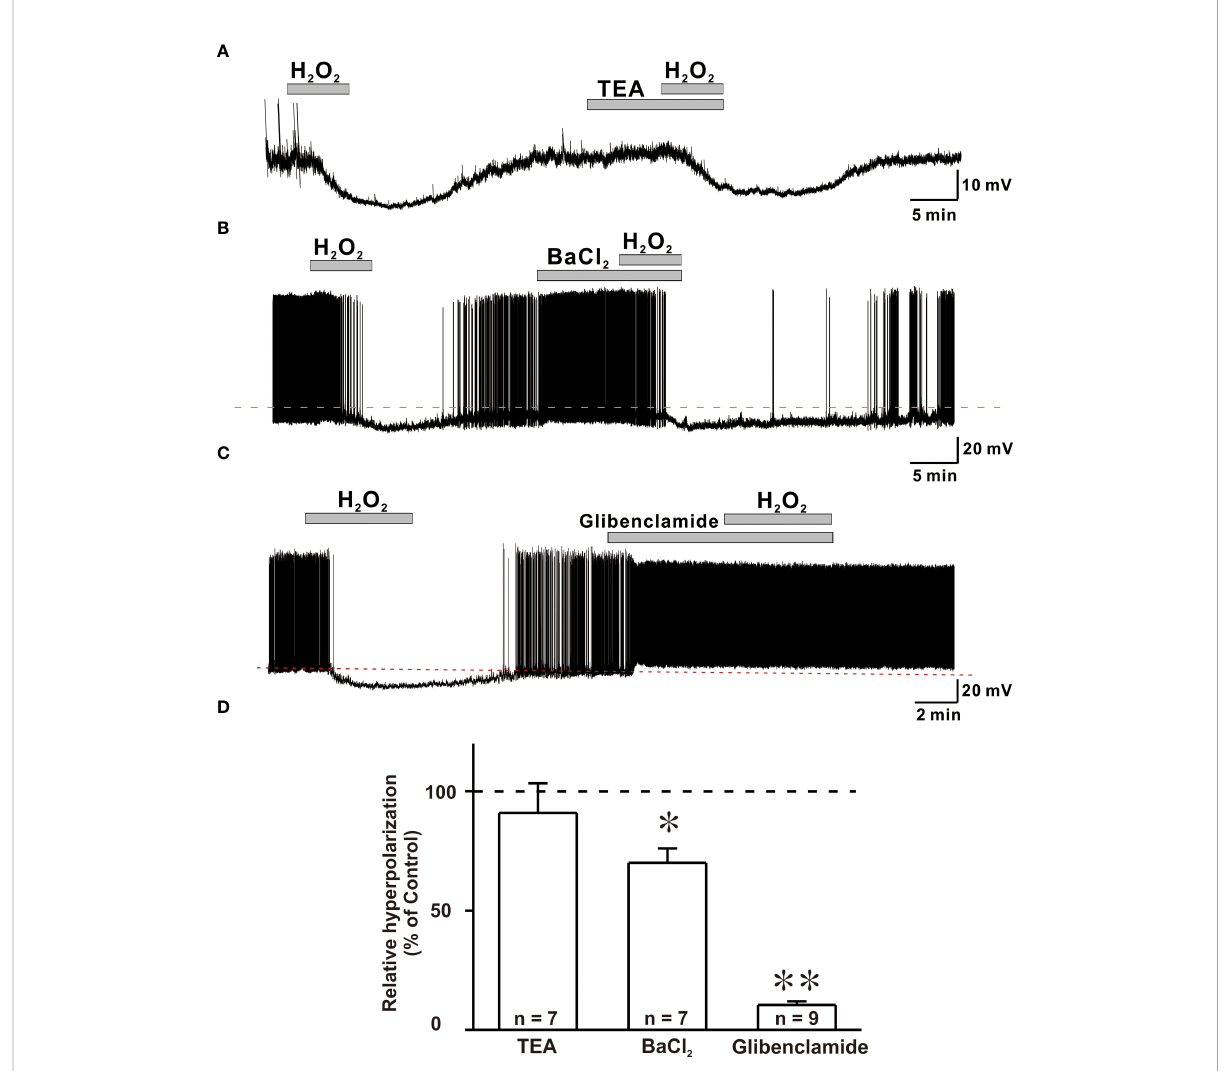
FIGURE 5 ATP-sensitive potassium channels (KATP) are susceptible to H2O2-induced hyperpolarization in GnRH neurons. (A, B) Representative traces showing persistence of H2O2-induced hyperpolarization response in the presence of TEA and BaCl2, respectively. (C) A representative trace showing complete blockade of hyperpolarization induced by 1mM H2O2 by KATP channel blocker glibenclamide under whole-cell current clamp. (D) A bar diagram depicting mean relative values of hyperpolarization caused by 1 mM H2O2 in the presence of various potassium channel blockers (TEA: n = 7, no signi fi cant; BaCl2: n = 7, *p < 0.05; glibenclamide: n = 9, **p < 0.01, paired